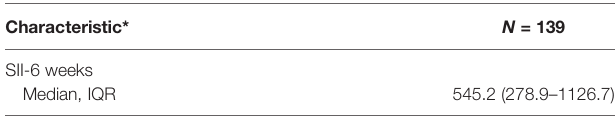
TABLE 1 | Characteristics of advanced gastric cancer